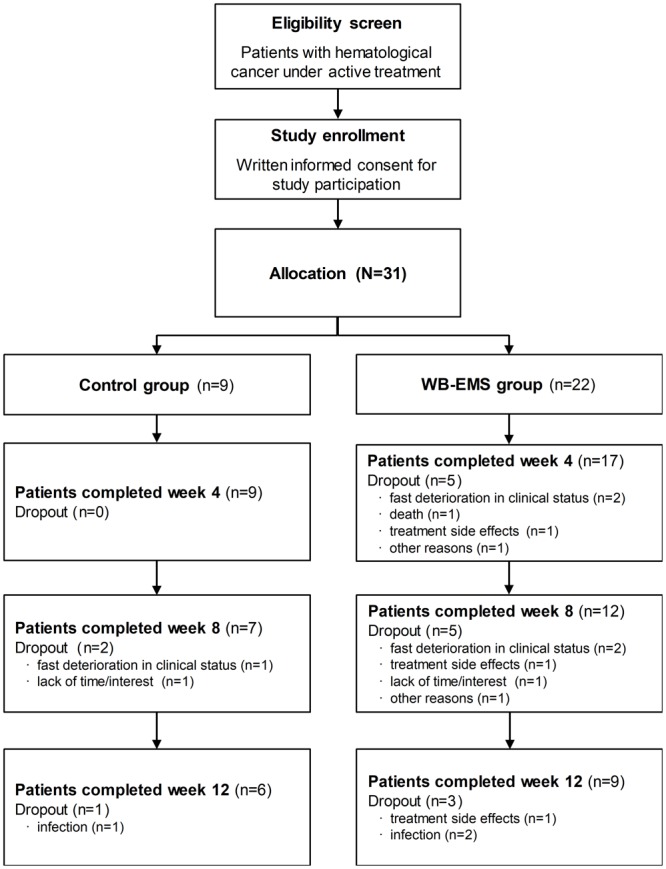
Patient flowchart. The flowchart shows the number of the allocated patients and the number of patients who dropped out during study course with dropout reasons and the number of patients who completed the whole intervention period of 12 weeks. During the study, body composition analysis was missed by 1 patient of the WB-EMS group at week 4 and 1 control and 2 WB-EMS patients at week 8. WB-EMS, whole-body electromyostimulation.